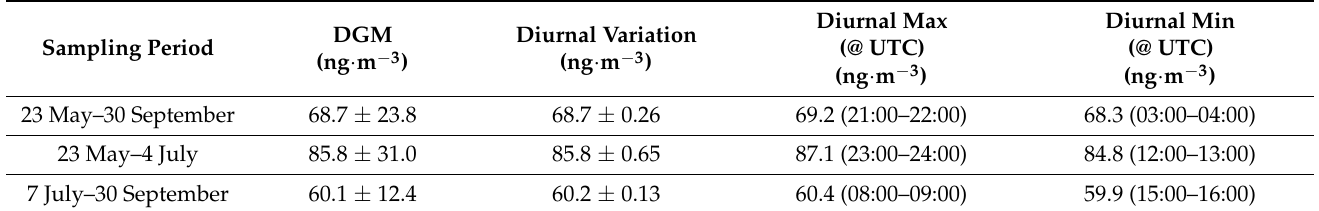
Table 1. Diurnal DGM variation across the entire sampling period and the two subintervals with statistically significant difference ( p < 0.01) in concentrations.